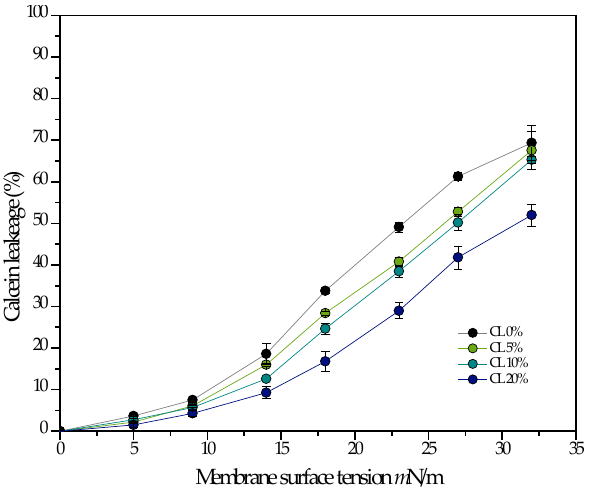
Figure 4. The percentage of leakage is measured as a function of membrane tension induced by osmotic stress in 100 nm liposomes composed of pure DMPG, and DMPG with varying amounts of CL. All measurements were performed at 37 °C.